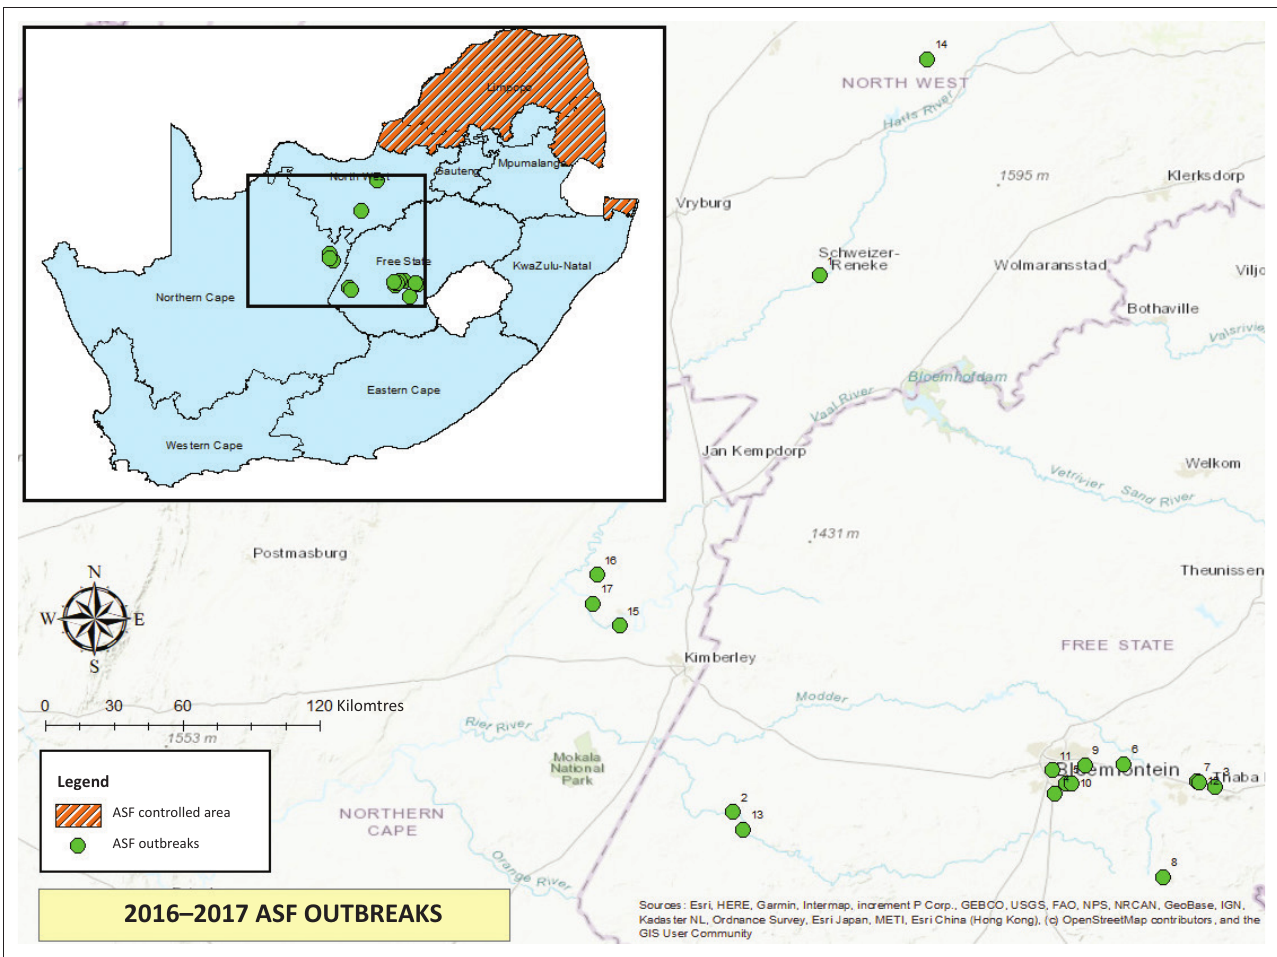
FIGURE 3: Map of 2016–2017 African swine fever epidemic